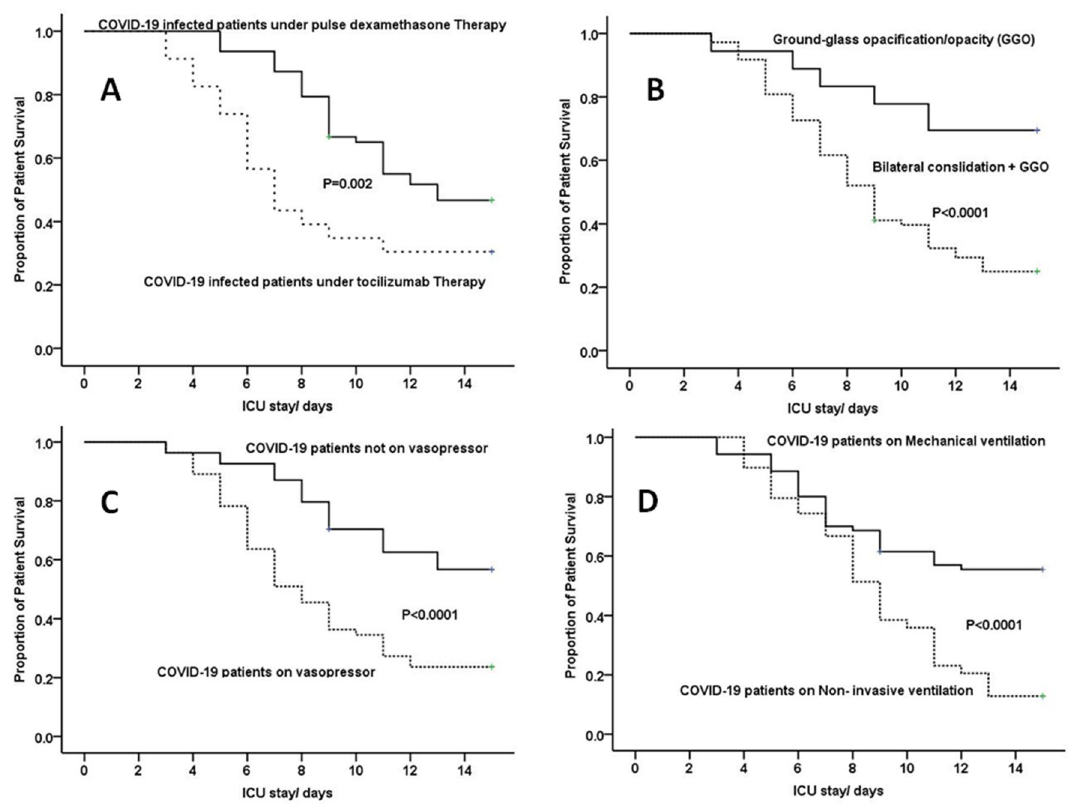
Figure 3. Showed Kaplan–Meier survival curve of critically ill COVID-19 patients, ( A ) for patients who received Toclizumab compared to those received pulse Dexamethasone ( P = 0.002). ( B ) for patients with CT Chest showing Ground glass opacities (GGO) compared with bilateral consolidation, ( P < 0.0001). ( C ) patients who do not need vasopressors at admission and those who need vasopressors at admission ( P < 0.0001). ( D ) patients on mechanical ventilation compared to those on Non-invasive ventilation ( P < 0.0001).